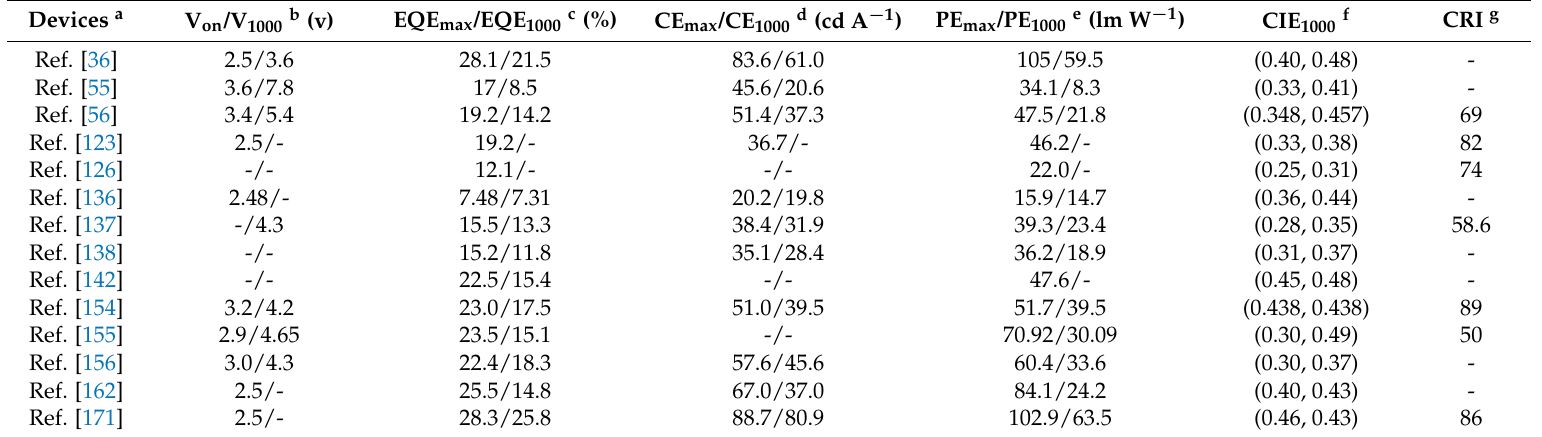
Table 1. Summary of the performances of WOLEDs based on